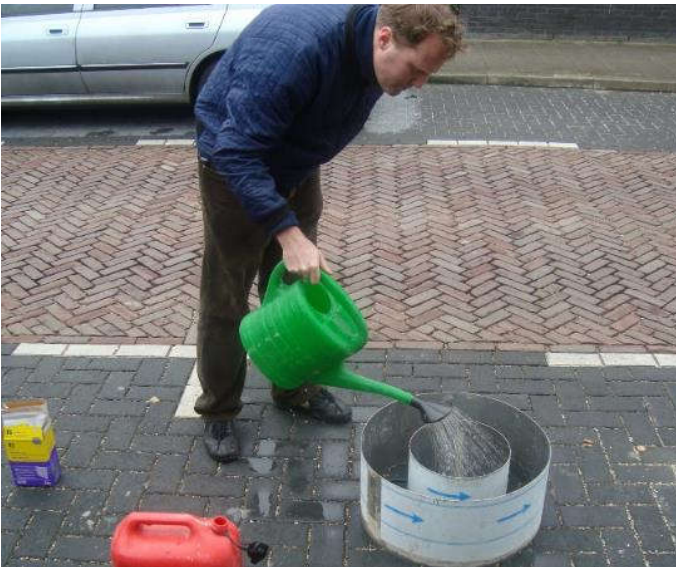
Figure 4. Double-ring infiltrometer tests .